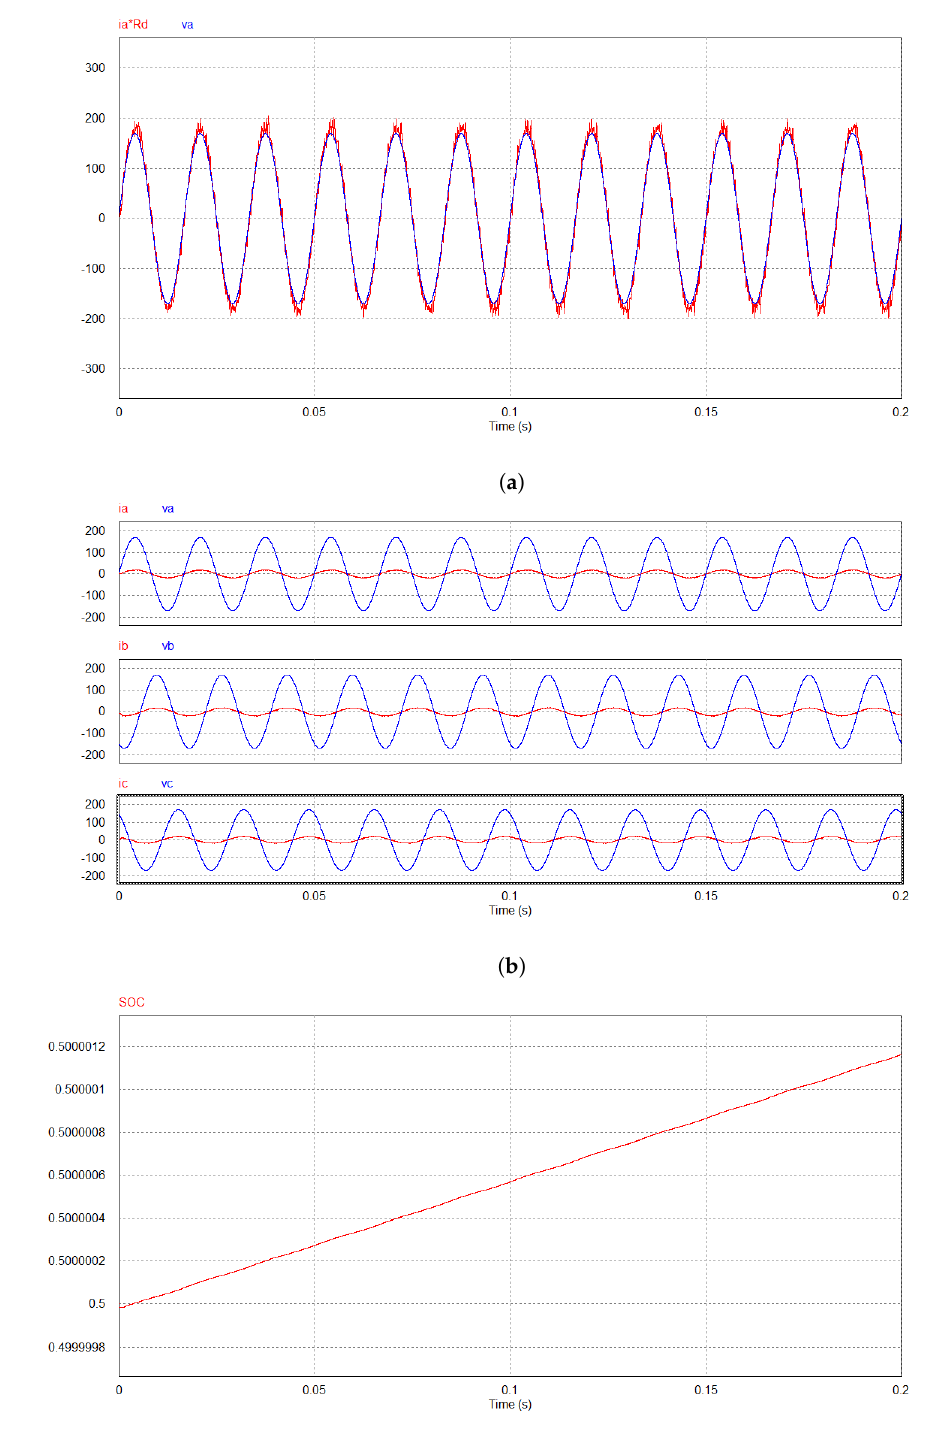
Figure 5. Simulation results for R d = 10 Ω . ( a ) The voltage of Phase-a and its current multiplied by R d . ( b ) The input voltage and current of each phase. ( c ) The battery state-of-charge